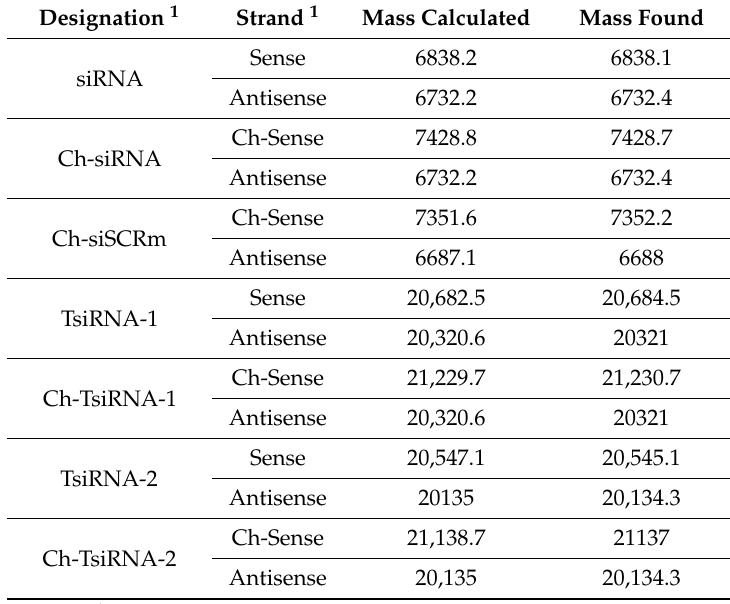
Table 2. Strands of small interfering RNAs (siRNA)